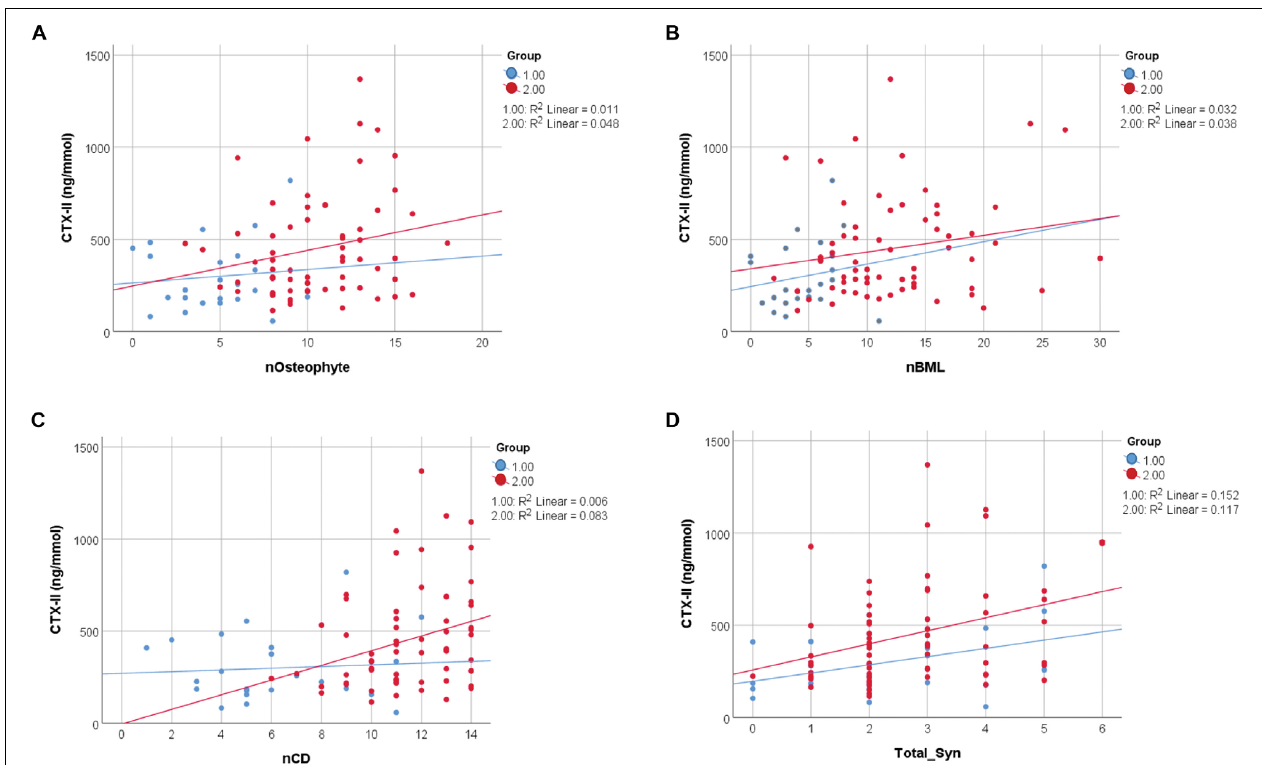
FIGURE 3 | Relation of CTX-II to MRI-defined structural damage in knee OA. Pearson correlation of CTX-II levels with (A) the number of osteophytes (nOsteophyte) ( p = 0.003), (B) the number of bone marrow lesions (nBMLs) ( p = 0.005), (C) the number of regions of cartilage degradation (nCD) ( p = 0.002) and with (D) the total synovitis total_Syn ( p = 0.001). Group 1, mild OA group; Group 2, advanced OA group; Syn, synovitis; BML, bone marrow lesion; CD, cartilage degradation; Ost,